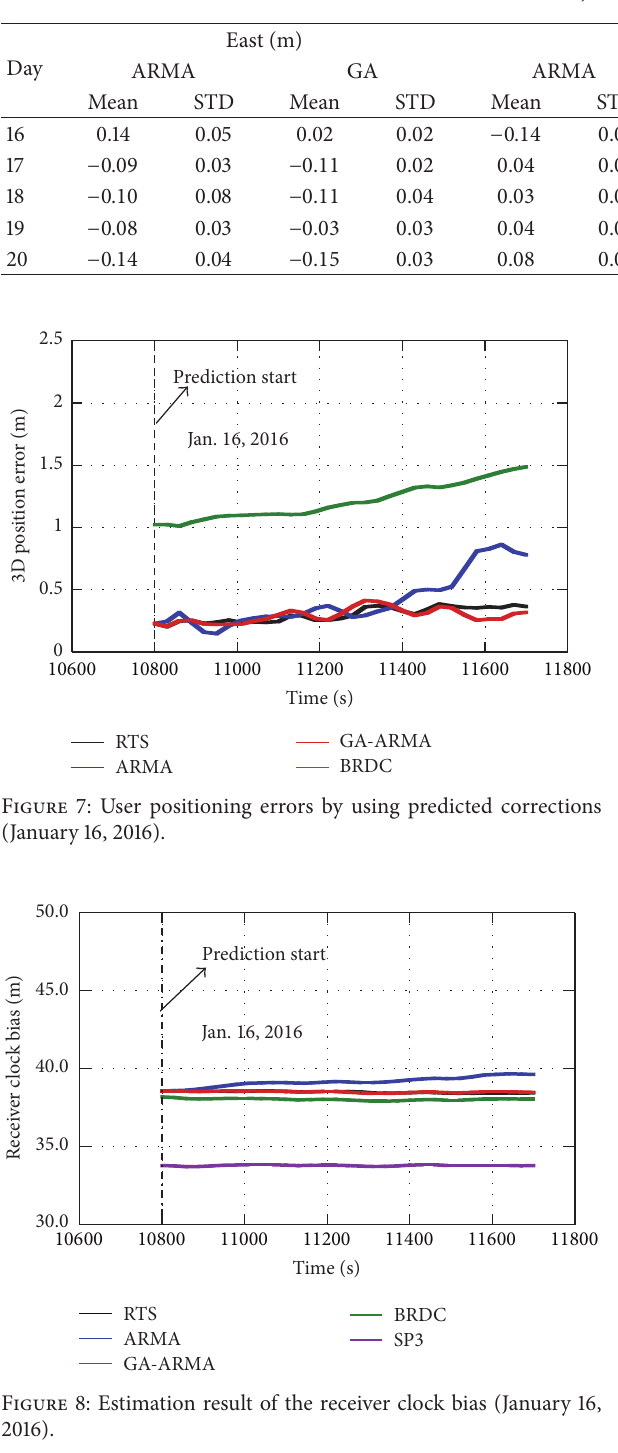
900 s. This increase is similar to the ARMA clock prediction error increase. Figure 9 represents the trace of horizontal positioning errors from January 16 to 20 in 2016. The error trace of the raw RTS is within 0.04 m, and it overlaps with other traces.